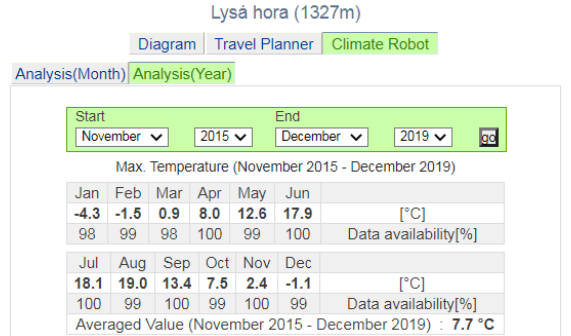
Figure 8. Calculation of the average outdoor temperature in Scenario 2 [18].